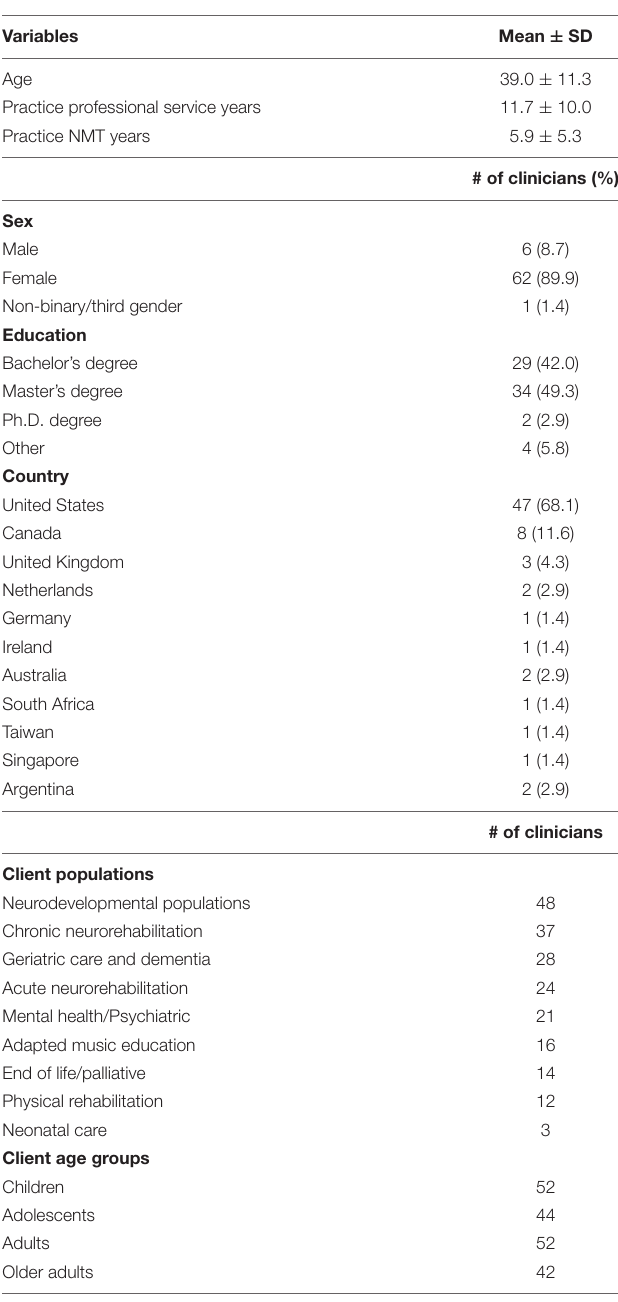
TABLE 1 | Demographic data for neurologic music therapists ( N = 69).